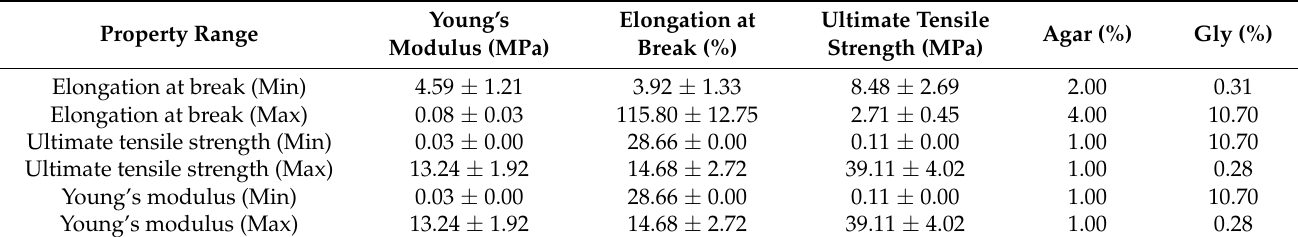
Figure 1. Average engineering stress as a function of engineering strain for a concentration of 2% agar and 1.25% glycerin. The blue line represents the linear portion or elastic zone, and the grey shaded region corresponds to the experimental error. Table 3. Range of mechanical properties of agar biopolymer films ( ± standard